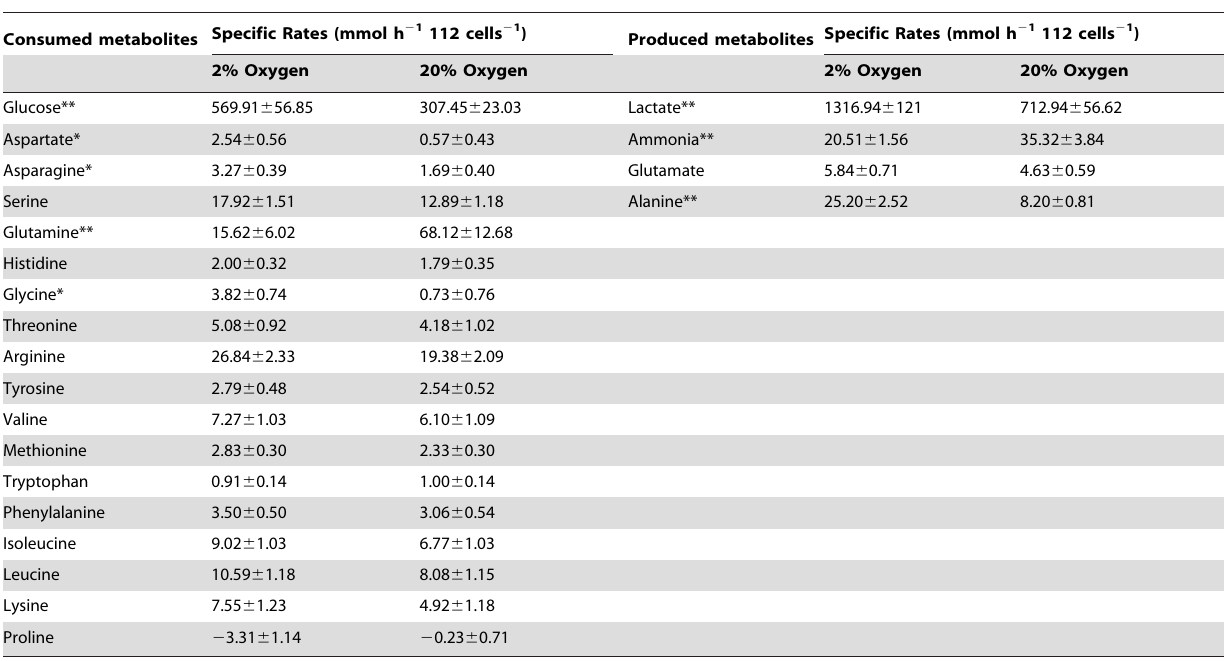
Table 1. Flux of major metabolites consumed and produced by human embryonic stem cells cultured at physiological and atmospheric oxygen concentrations.